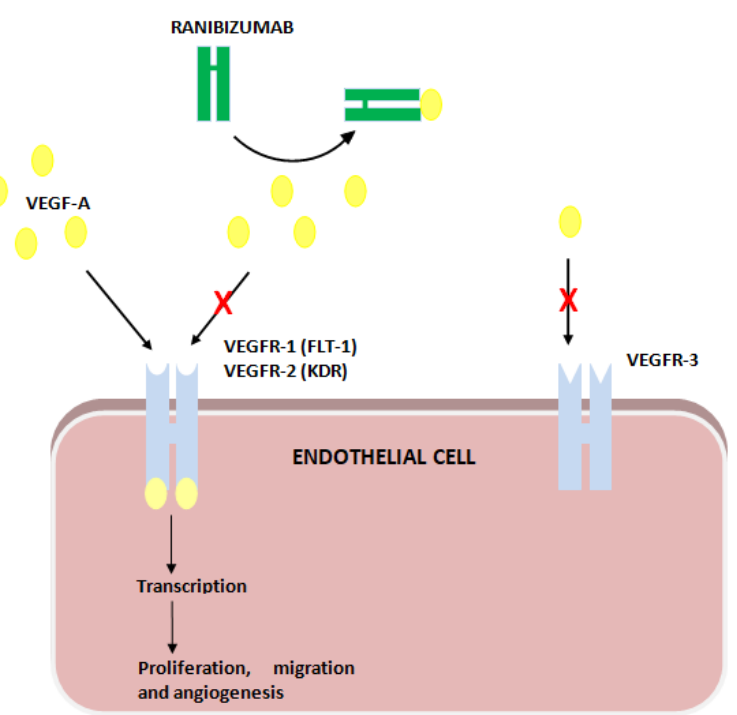
Figure 1. Ranibizumab’s action on VEGF receptors (VEGFR).